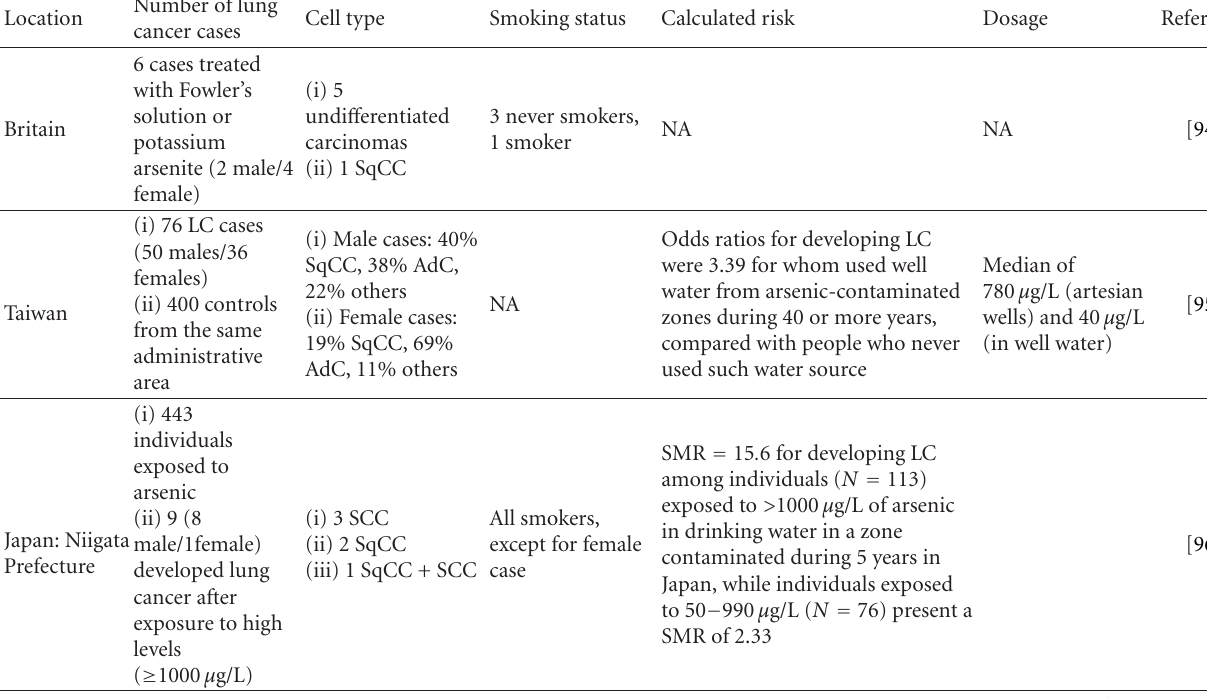
Table 1: Studies exhibiting associations between arsenic exposition and cell types of lung